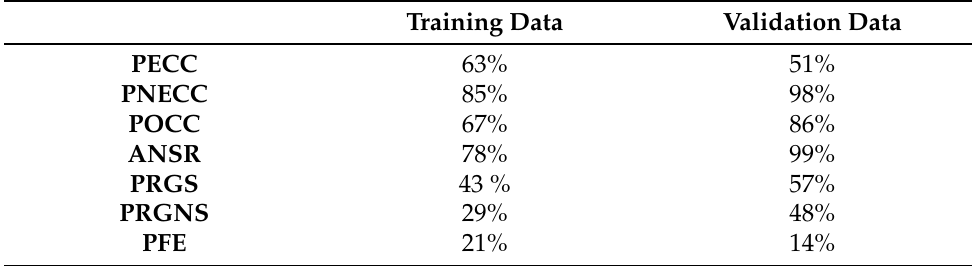
Table 7. Performance of the